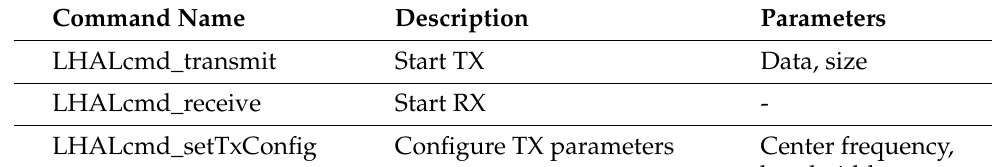
Table 1. The LHAL command